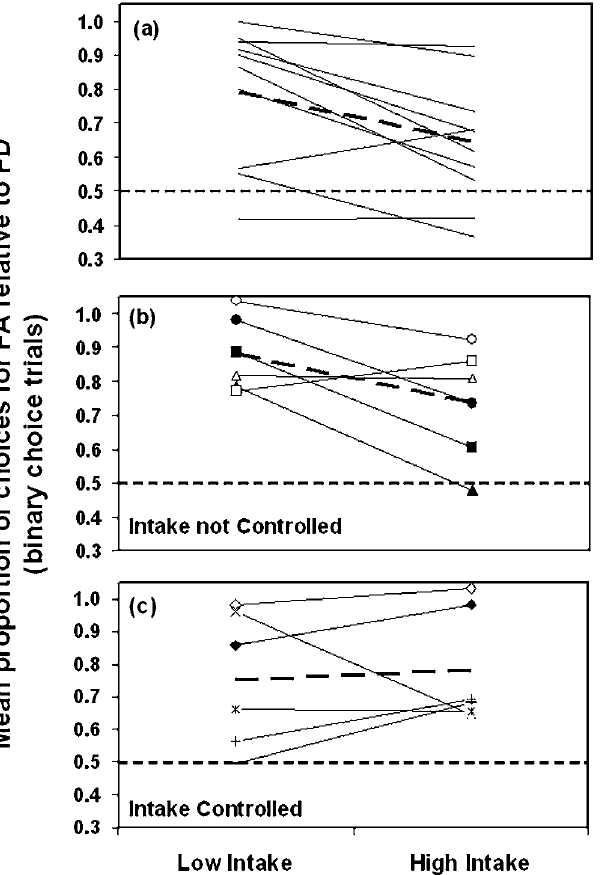
Figure 3. Individual Proportion of Choices for FA Relative to FD in Treatments ‘‘ High Intake ’’ and ‘‘ Low Intake ’’ (A) Effect of intake on choices without decoys. Here, extra food simulates the intake consequences that the two decoys cause when they are present and consumed on 25% of the feeding opportunities ( p , 0.01). (B) Results of an experiment with decoys when energetic consequen- ces of the decoys were allowed to take effect (group NC) ( p = 0.06). (C) Results of an experiment with decoys, similar to (B), in which the energetic consequences of the decoys were abolished (group C). In (B) and (C), each symbol corresponds to each of the subjects. The dashed lines show the mean values in each of the